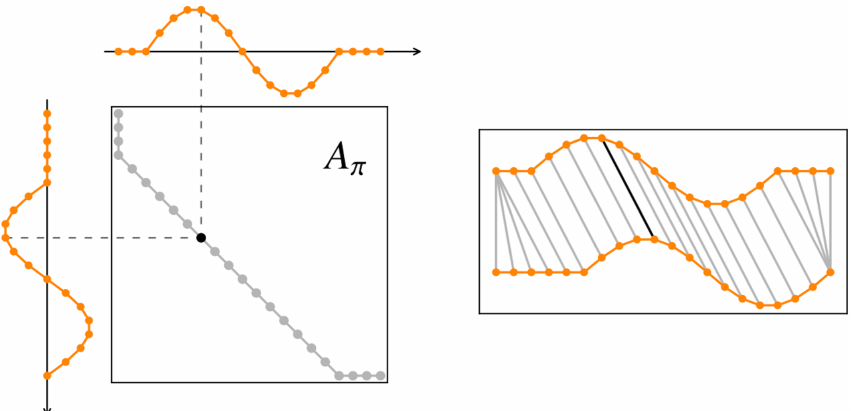
Figure 4. The warping path to minimize the cumulative distance between two time series is de- termined by the dynamic time warping (DTW) in the n-by-m matrix, reproduced with permission from [14], copyright from Professor Romain Tavenard 2023. The dot on A π indicates the optimal alignment of an element in x with an element in x (cid:48)